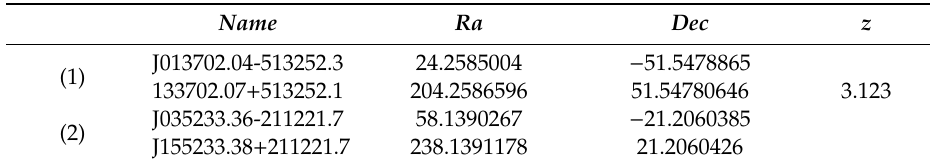
Table 15. Pairs of opposite quasars from the KQCG catalog [48] with the best positional accuracy for the lens e ff ect. Accuracy is of 0.0001 ◦ for ra and dec . Redshift z is given when available, although not essential here.